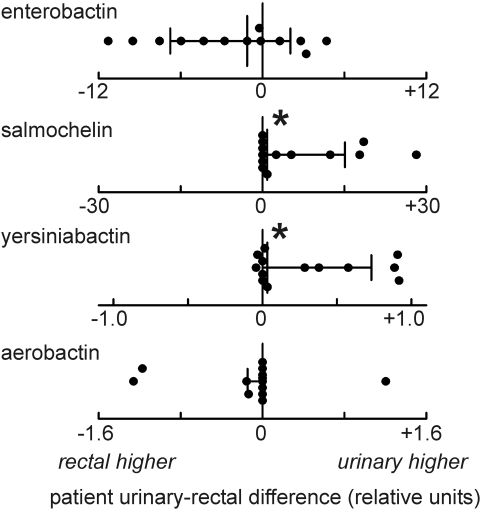
Differences in siderophore production between single-patient urinary and rectal isolates.Each data point is the difference in siderophore production between coincident urinary and rectal strains recovered from an individual with UTI. These differences were determined by stable isotope dilution mass spectrometry and expressed in reference strain equivalents. The median and interquartile range is depicted for each siderophore. *Medians differs significantly (p<0.05) from zero.